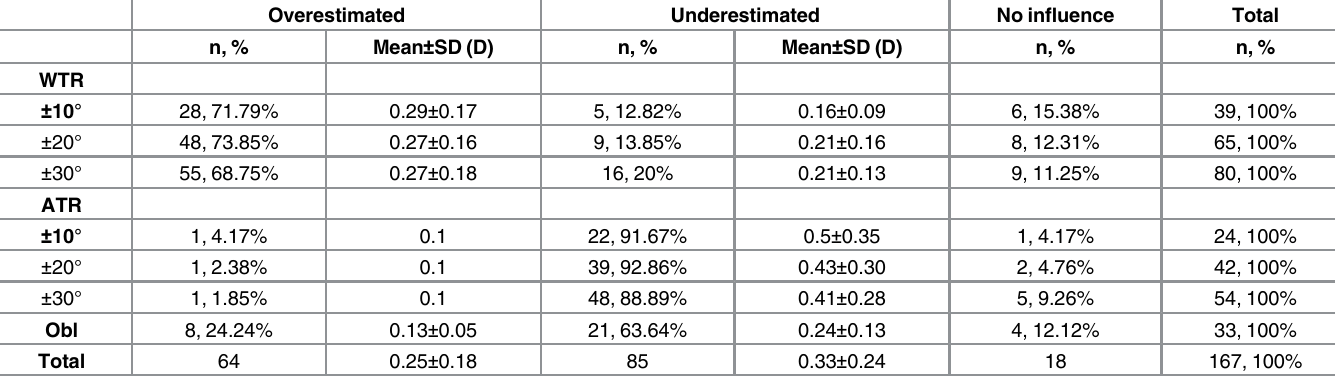
Table 5. Anterior corneal measurement estimations of total corneal astigmatism by steepness of corneal meridian.